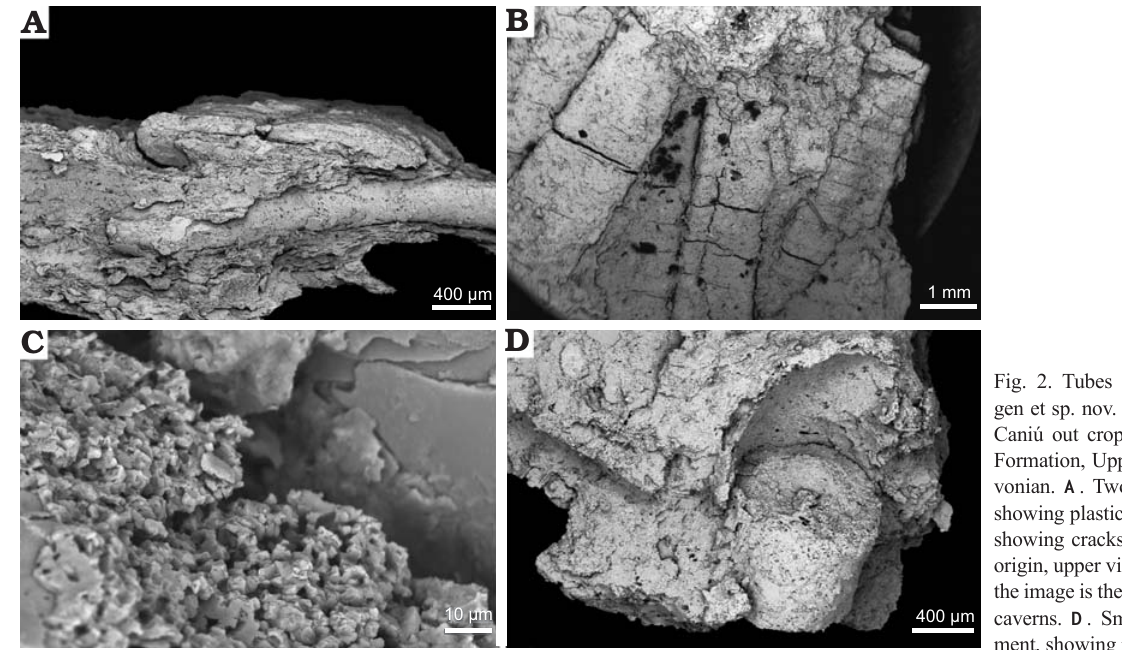
Fig. 2. Tubes of Annulitubus mutvei gen et sp. nov. (MN 9571-I) from Rio Caniú out crop, Brazil; Ponta Grossa Formation, Upper Emsian, Lower De- vonian. A . Two tubes in lateral view showing plastic deformation. B . Tubes showing cracks of possible diagenetic origin, upper view. C . Middle to left of the image is the tube’s surface showing caverns. D . Small circular tube frag- ment, showing no lateral thickenings.